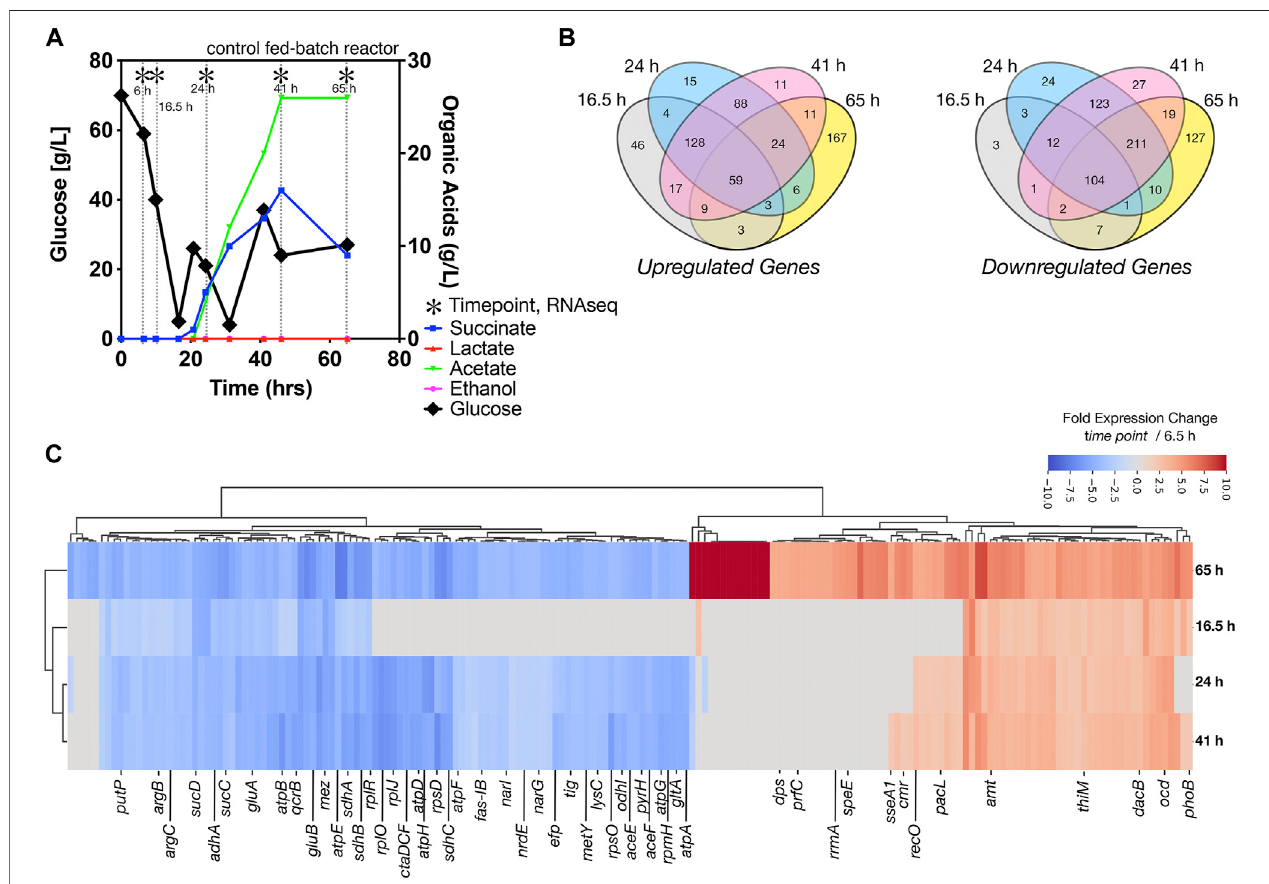
FIGURE 4 | Growth of engineered C. glutamicum for IP in a control stir tank bioreactor, (A) HPLC analysis of glucose and organic acids detected in the 2 L stirred tank bioreactor. Cells were harvested from the indicated time points with (*). Refer to Figure 5A for the [Ch][Lys] treated bioreactor. (B) Shared and unique differentially expressed genes. Venn diagrams indicate thenumber ofUpregulated ( left) and downregulated( right) genesat the indicated time points, (C) Hierarchical cluster analysis of the top 181 differentially expressed genes at the 65-h time point vs. the 6.5 h time point for both up or down regulation. A number of genes that are highly expressed only in stationary phase vs constitutively expressed are